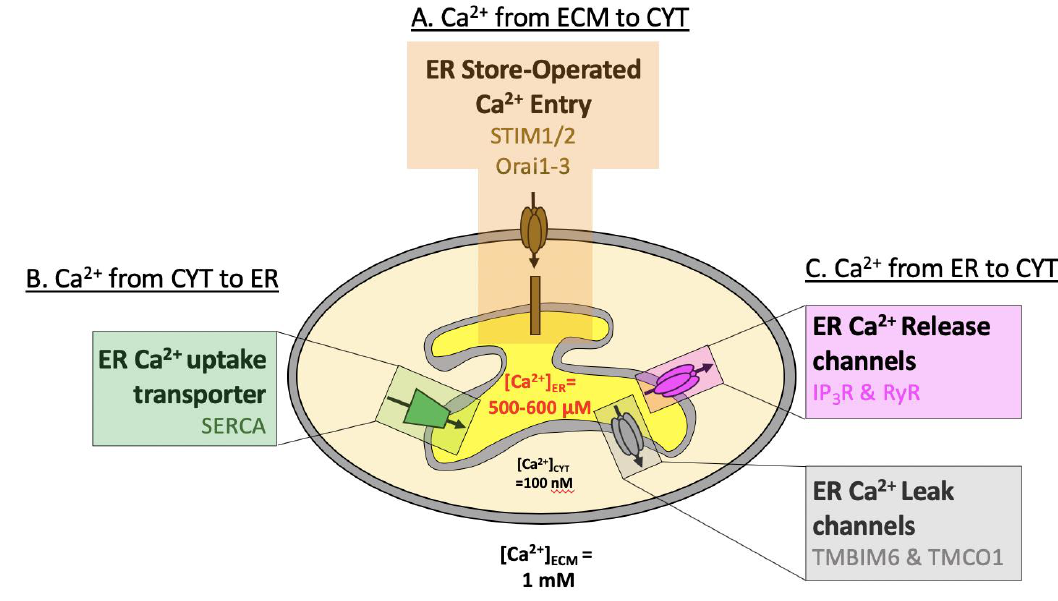
Figure 1. Overview of ER Ca 2 + handling. Schematic presentation of Ca 2 + concentrations in the endoplasmic reticulum (ER, 0.6 mM) compared to the cytosol (CYT, 100 nM) and extracellular milieu (ECM, 1 mM). ( A ) Ca 2 + flows down its electrochemical gradient from the ECM to CYT (through Orai) or ( B ) against its electrochemical gradient from the CYT to the ER (through SERCA). ( C ) Ca 2 + flows from the ER to the CYT down its electrochemical gradient, either following the activation of IP 3 R & RyR, or through ER Ca 2 + -leak channels TMBIM6 & TMCO1.